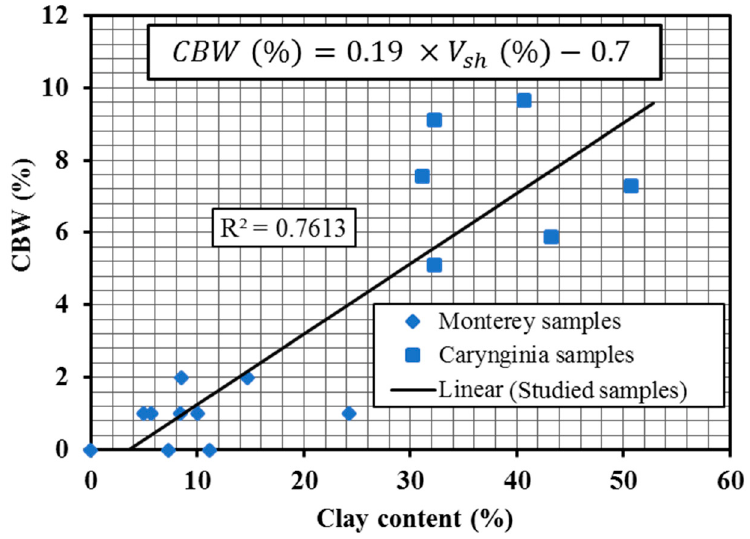
Figure 11. The cross-plot of clay bound water (CBW) (%) versus clay content (%) for studied shale samples.